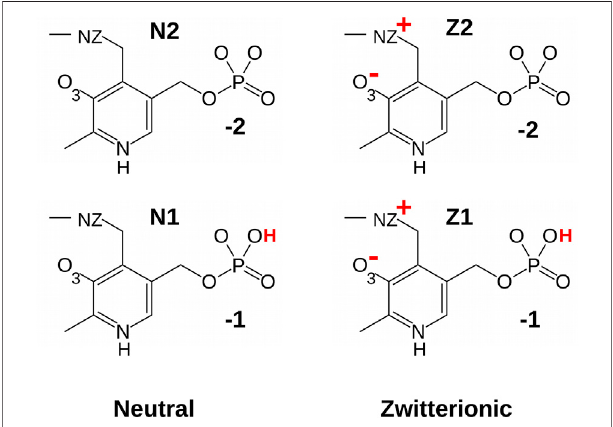
FIGURE 1 | PLP protonation states considered in this